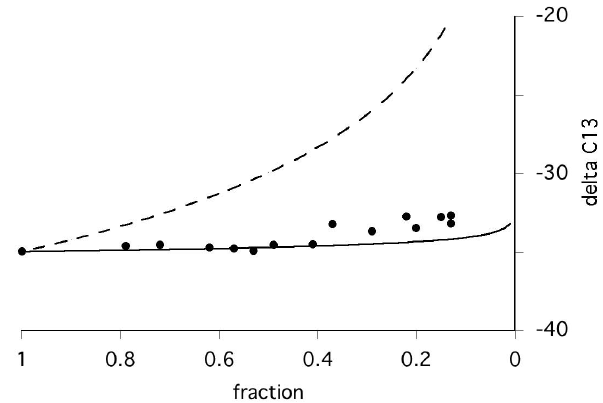
Fig. 9. Fraction of methane oxidised in waters of Buor-Khaya Bay in 2010. The endmember of the Rayleigh curve is based on the data set with the highest methane concentration (102nM) and the corre- sponding isotope signature of − 34.96‰ VPDB. The curves show the prospective δ 13 C signatures modified by diffusion ( α =1.0009, solid line) or oxidation ( α =1.017, dashed